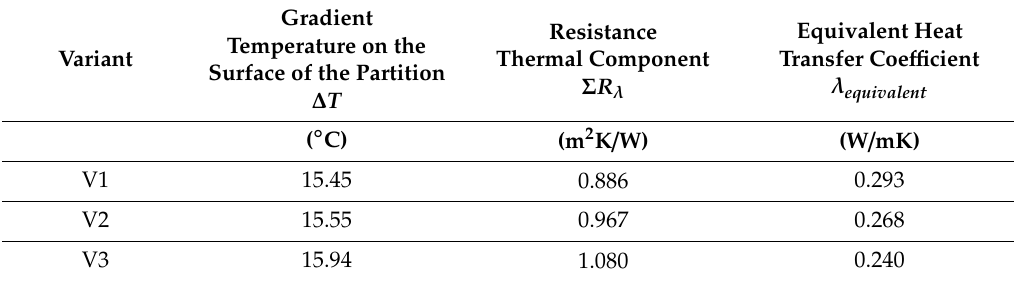
Equivalent Heat